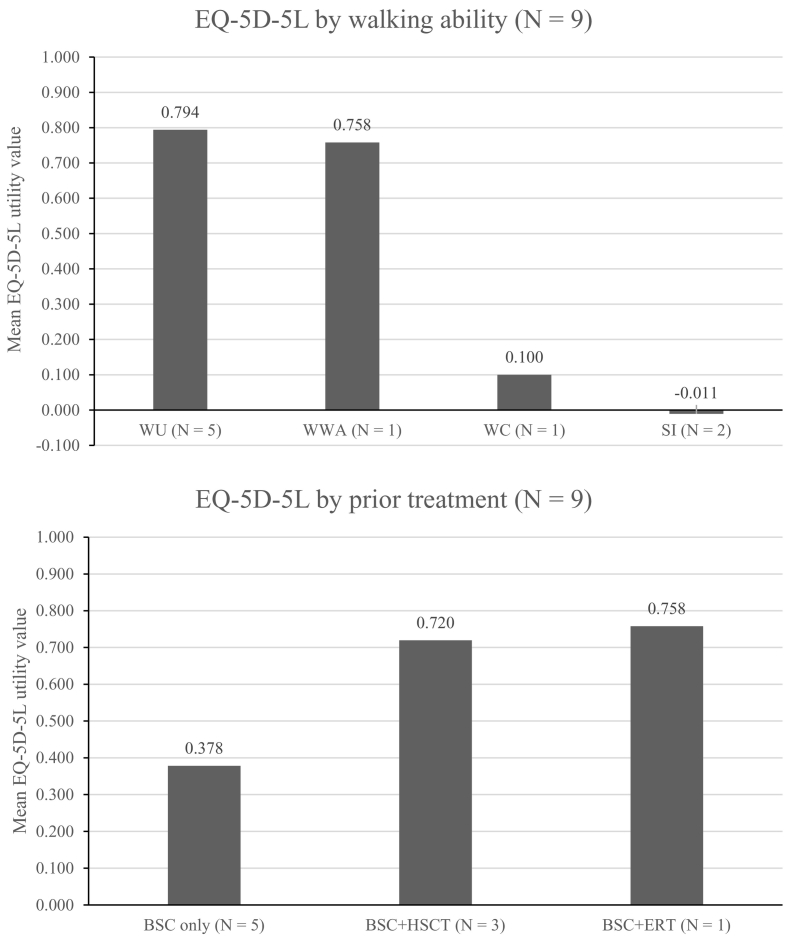
HRQoL of nine patients as reported by proxy measured using the EQ-5D-5 L questionnaire according to walking ability (top) and prior treatment (bottom). A score of 1 indicates ‘perfect health’, a score of 0 indicates ‘death’. Negative values indicate ‘feeling worse than death’. Utility values for two patients were mapped from EQ-5D-Y to EQ-5D-5 L using the nonparametric crosswalk method [15].Abbreviations: BSC, best supportive care; EQ-5D-5 L, EuroQol 5 Dimensions 5 Levels; ERT, enzyme replacement therapy; HRQoL, health-related quality of life; HSCT, haematopoietic stem cell transplantation; SI, severe immobility; WC, wheelchair-dependent; WU, walking unassisted; WWA, walking with assistance.